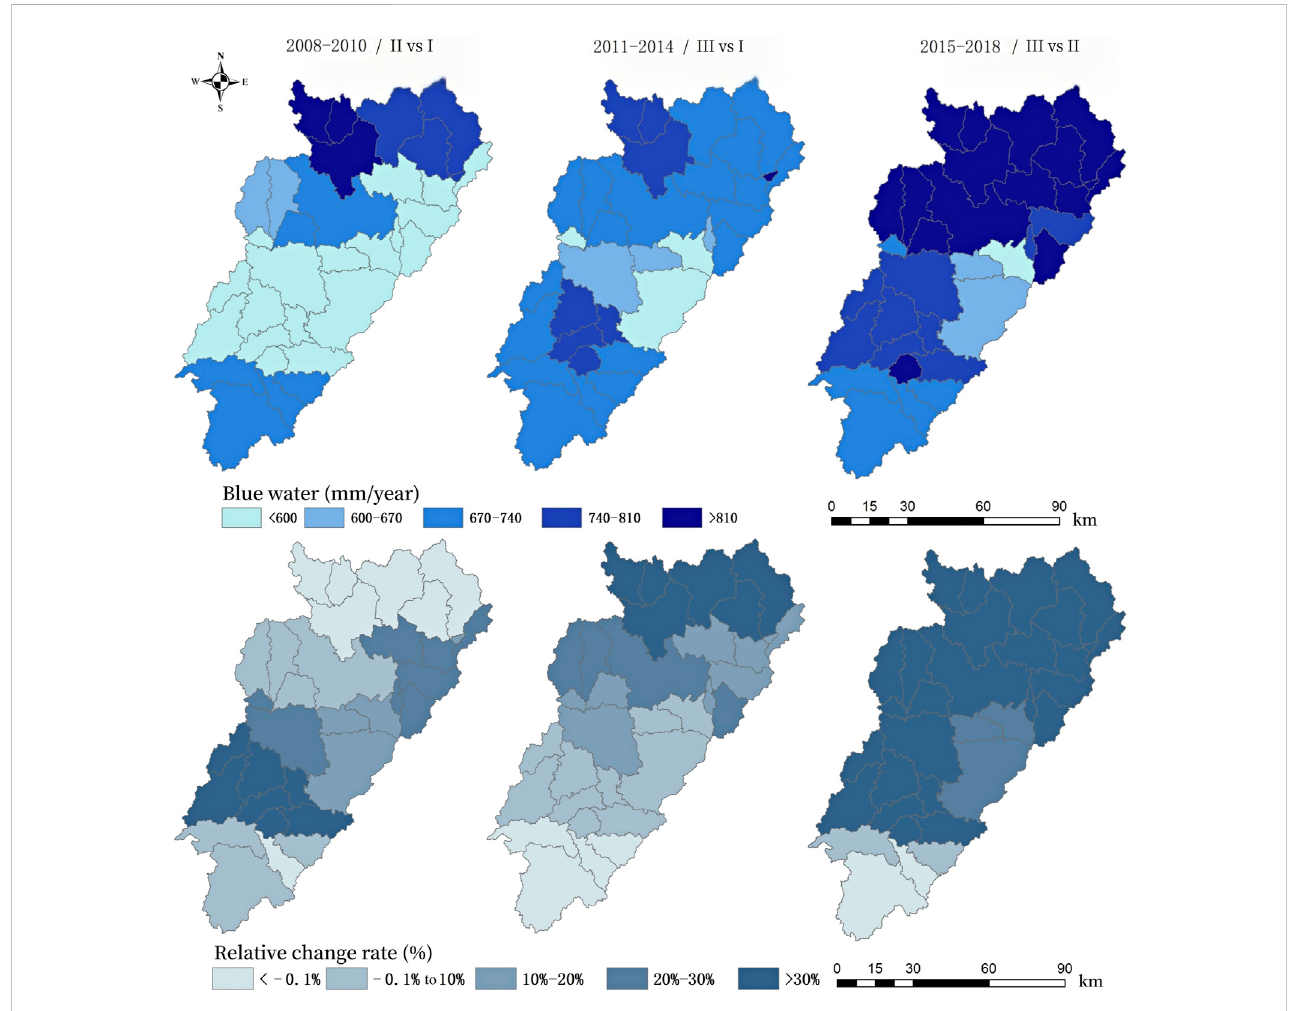
FIGURE 6 Spatial distribution of blue water volume and relative rate of change in the Meijiang River